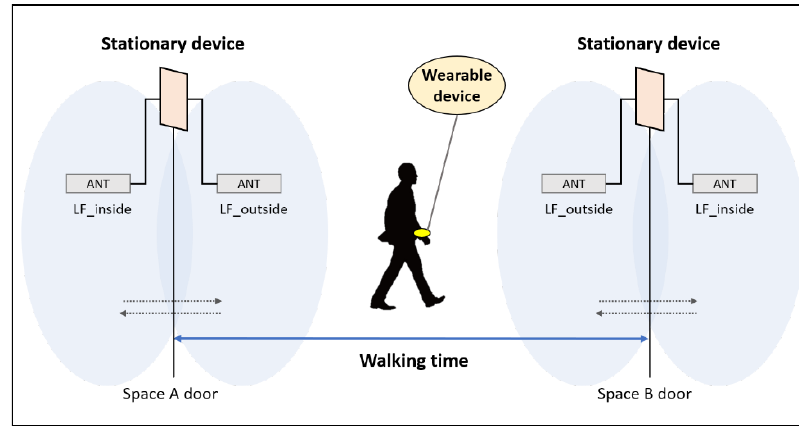
Figure 4. Estimating walking speed.